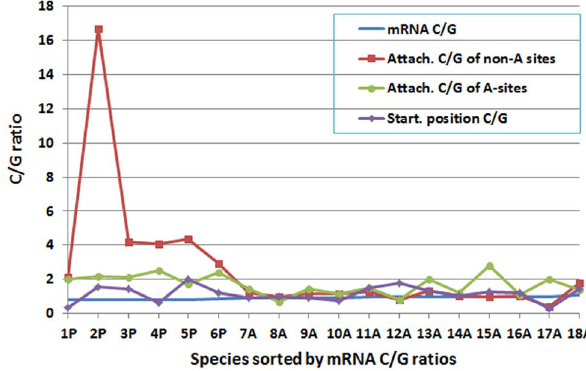
Figure 2. The C/G ratios (sorted from smallest ( # 1) to largest ( # 18) in messenger RNA (mRNA) sequences, the polyadenyl- ation [poly(A)] tail attachment position of A-type poly(A) sites, the poly(A) tail attachment position of non-A-type poly(A) sites, and the poly(A) tail starting position. P: plant; A: animal. Species order from 1 to 18 is Medicago truncatula (1P), sorghum (2P), rice (3P), poplar (4P), maize (5P), Arabidopsis thaliana (6P), chicken (7A), zebrafish (8A), orangutan (9A), zebra finch (10A), human (11A), rabbit (12A), pig (13A), cattle (14A), rat (15A), mouse (16A), dog (17A), and fruit fly (18A). Note that a) plants and animals are clearly separated by the mRNA C/G ratios; b) plants strongly selected C over G at the poly(A) tail attachment position when the tail starting position was not an A; c) plants still favourably selected C over G when the tail starting position was an A; d) plants usually (in four of six species) favoured C over G to